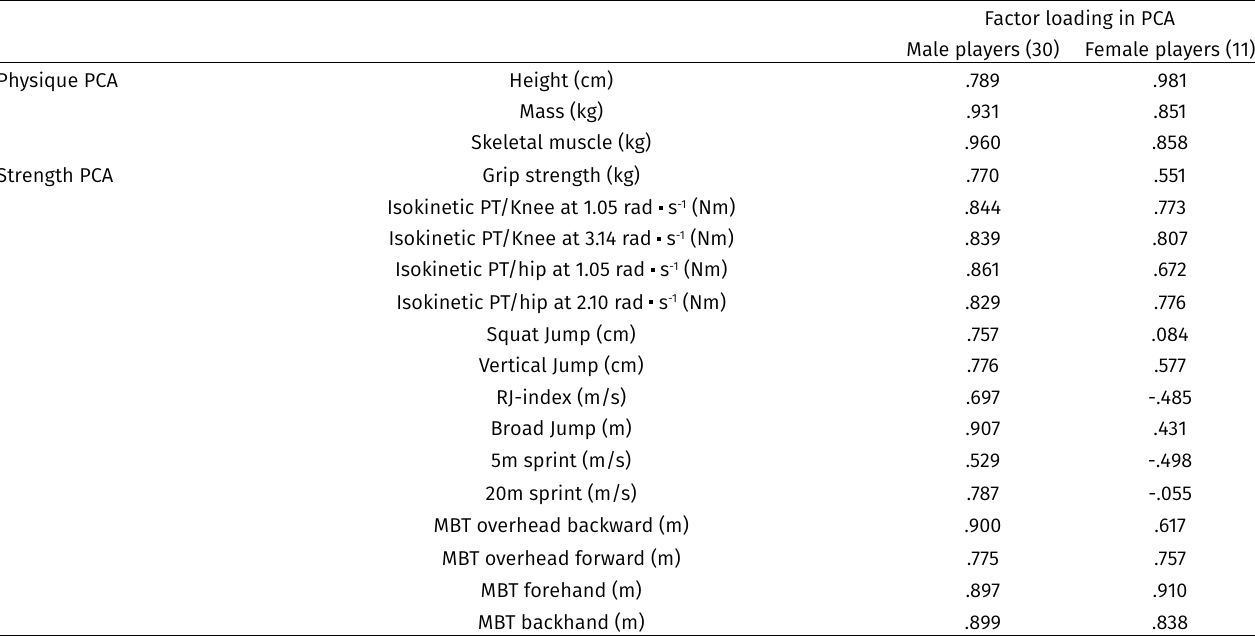
Table 3. Factor loading in physique PCA and strength